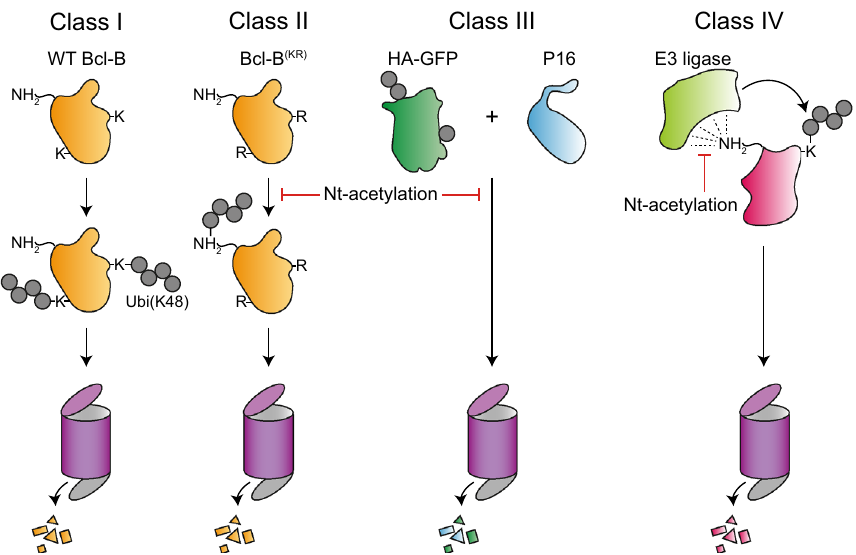
Figure 7. Model describing the interplay between Nt-acetylation, ubiquitination and protein stability. Based on the substrates studied, our data suggest that there are multiple classes of proteins that differ with regards to the impact of Nt-acetylation on protein stability, and its interplay with ubiquitination. Class I proteins, which include wild-type (WT) Bcl-B, are heavily modified by K48-linked ubiquitin chains targeting the substrate for proteasomal degradation. For Class I proteins, ubiquitination is the main determinant of protein stability and there is no impact of Nt-acetylation. Class II proteins are Class I proteins for which lysine ubiquitination is somehow prevented, like for a lysineless Bcl-B mutant (KR). Nt-acetylation inhibits degradation of Class II proteins by preventing ubiquitin conjugation to the N-terminus. Class III proteins might carry